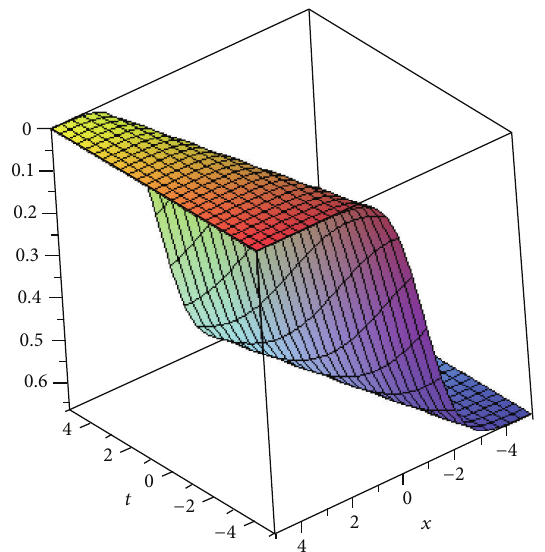
Figure 2: The plot of solution (27) with 𝛽 = 𝑅 = 𝑛 = 1 , and 𝛾 = −1 .